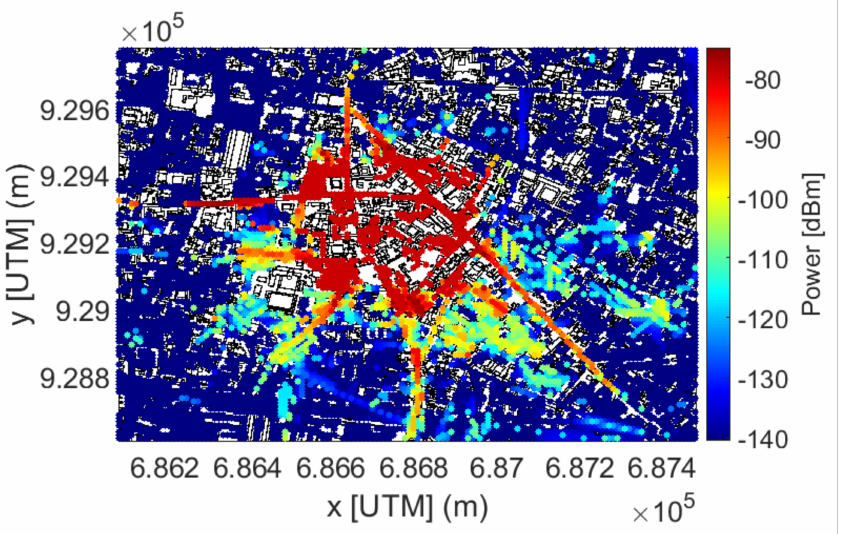
Figure 8. Example of coverage map at ground of an UAV flying over an urban area, generated with the DED-RL. UAV height: 150 m. The ABS antenna is pointed towards ground with a half-power- beamwidth of 80 ◦